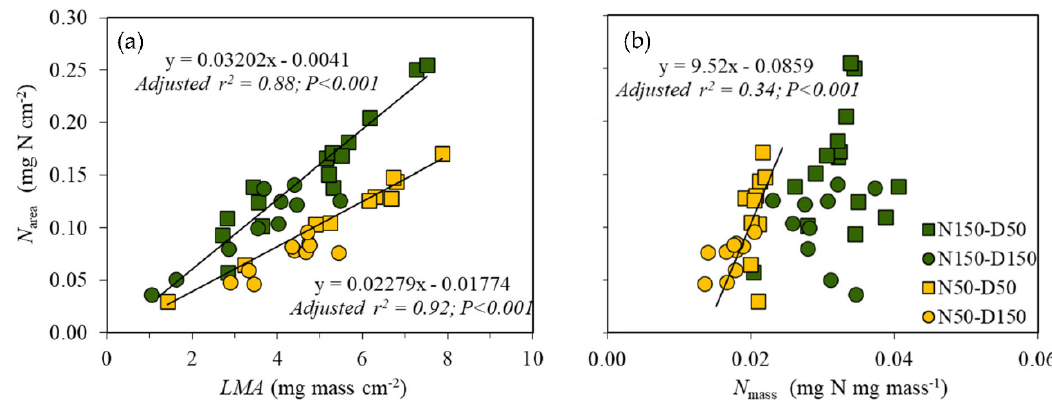
Figure 5. Leaf N content per unit of area ( N area ) versus ( a ) leaf mass per unit of area ( LMA ) and ( b ) N content per unit of mass ( N mass ) at 7 days before flowering (BBCH 62). Each symbol corresponds to an individual leaf.